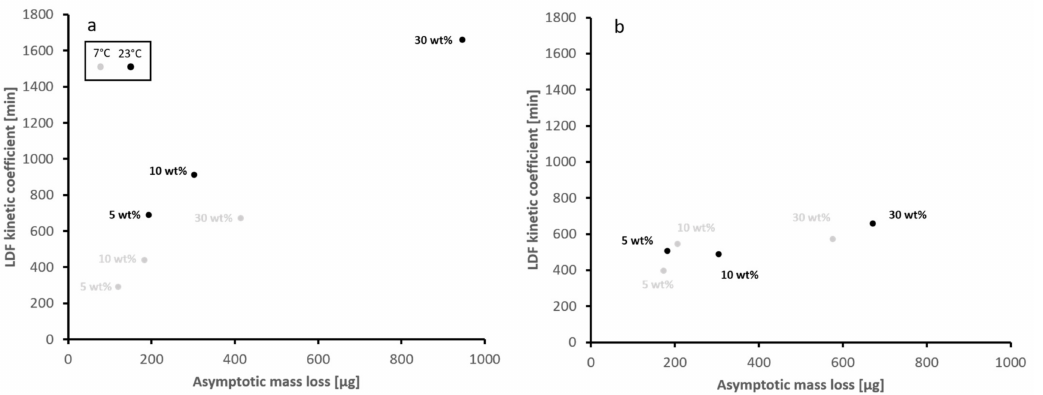
Figure 5. Linear driving force parameters deduced from the experiments for thyme oil ( a ) and rosemary oil ( b ). Every point indicates data for one degree of loading, as indicated in the